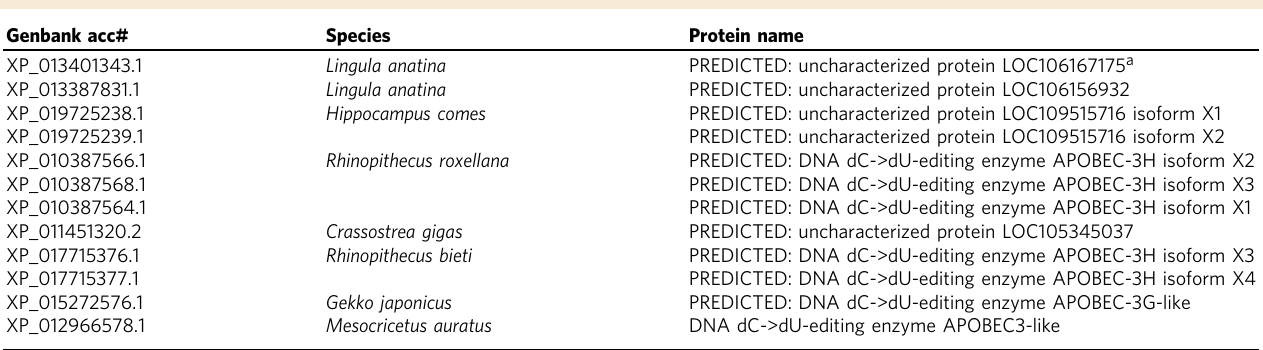
Table 1 Genbank entries with the highest similarity to LaAIDL2 (BLASTP) Genbank acc#